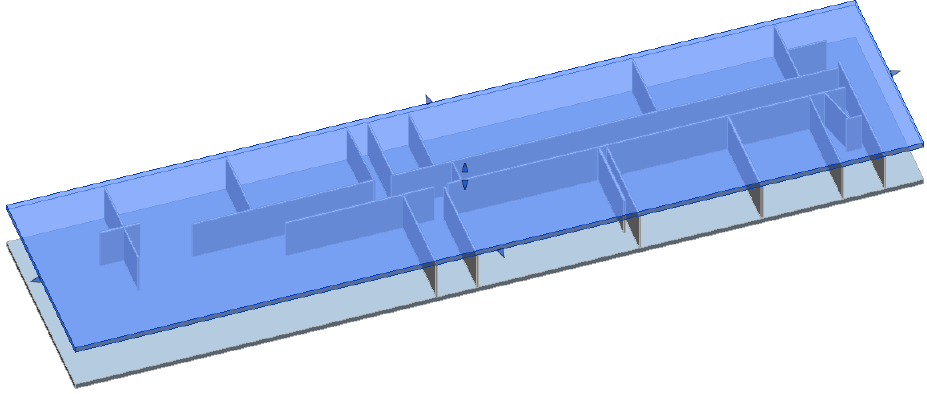
Figure 10. Rendering of the ifc file into Revit (Autodesk) —1st floor of the INSA